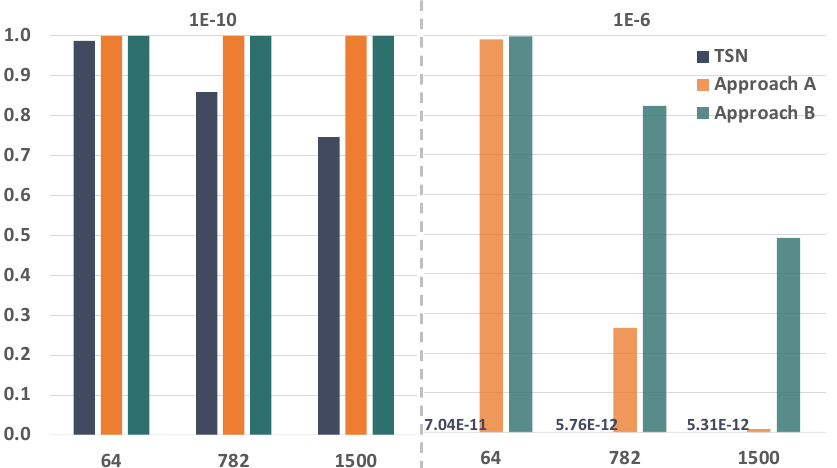
Figure 12. Reliability when varying the frame size. The left side of the figure shows the reliability for a BER of 1 × 10 − 10 , while the right shows the reliability for a BER of 1 × 10 − 6 . In both cases, TSN is represented in grey, approach A in orange and approach B in green. The x axis represents the frame sizes in bytes, while the y axis represents the